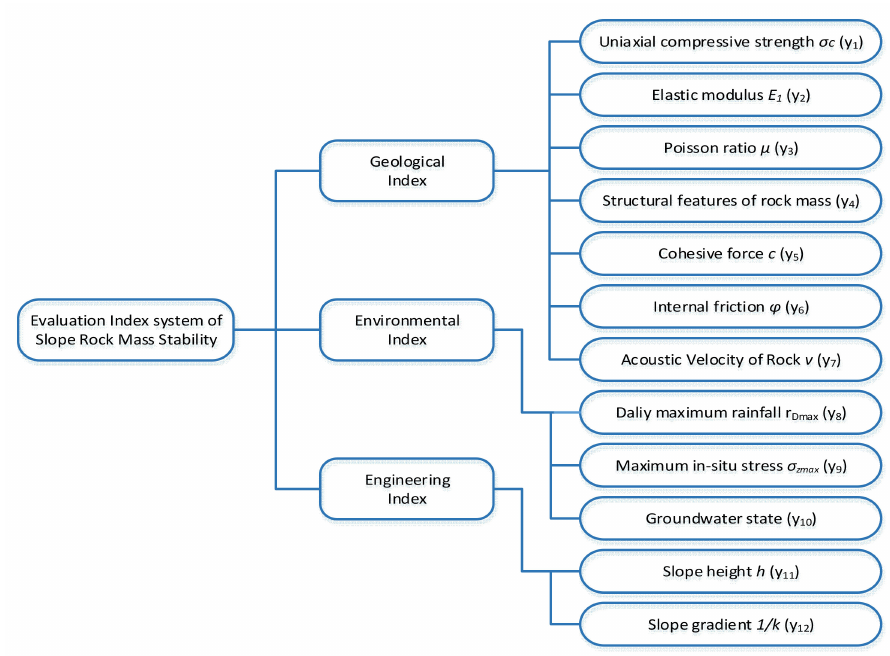
Figure 1. Evaluation index system of the slope rock mass